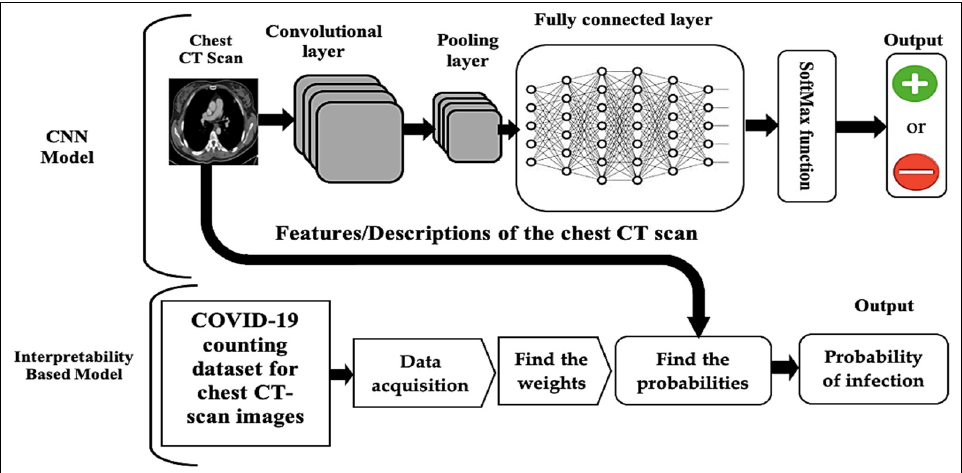
Figure 2. Using the interpretability-based model to interpret the predictions of the CNN model for COVID-19 patients given their chest CT images.